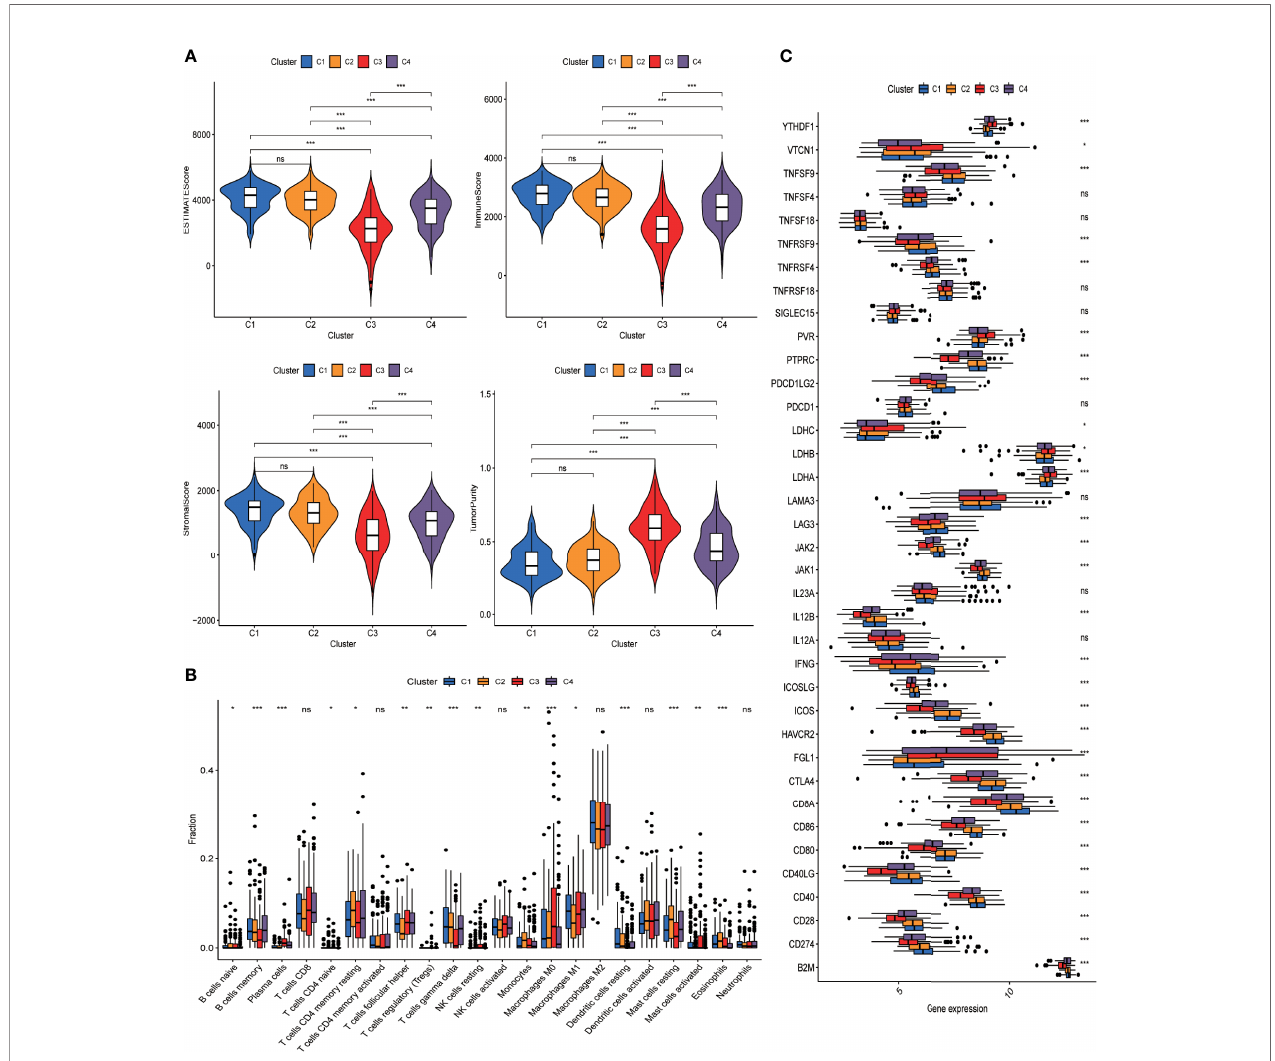
FIGURE 4 | DRG-based classi fi cation of LUAD patients and their corresponding tumor immune microenvironment. (A) Violin plots present the ESTIMATEscore of tumors from C1, C2, C3, and C4 clusters in the GSE72094 cohort. Intercluster comparison was performed using t test. *p < 0.05; **p < 0.01; ***p < 0.001; ns, not signi fi cant. (B) Boxplot showing the in fi ltrating fractions of 22 different subtypes of immune cells in the four groups of tumors. Between-group differences were evaluated using the Wilcoxon test. *p < 0.05; **p < 0.01; ***p < 0.001; ns, not signi fi cant. (C) Boxplot showing the expression levels of immune check point genes across four groups of tumors. Between-group differences were evaluated using Wilcoxon test. *p < 0.05; **p < 0.01; ***p < 0.001; ns, not signi fi